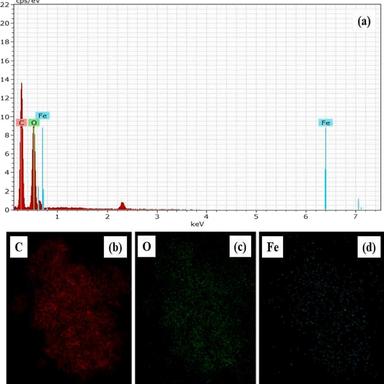
Presents the EDAX spectrum and corresponding mappings for the Fe-GO Nanocomposite as follows: (a) EDAX spectrum, (b) carbon mapping, (c) oxygen mapping, and (d) iron mapping.